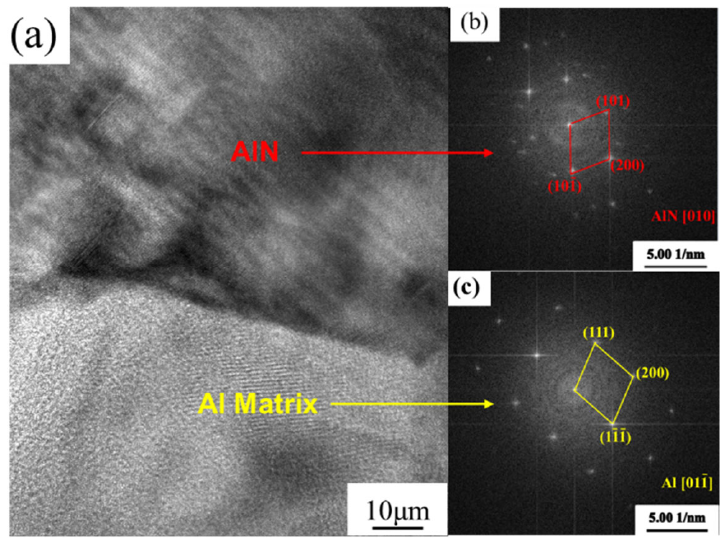
Figure 8. HRTEM of nano-AlN/AA6061 after HE: ( a ) Interface of nano-AlN and AA6061; ( b , c ) the FFT result of the selected region.